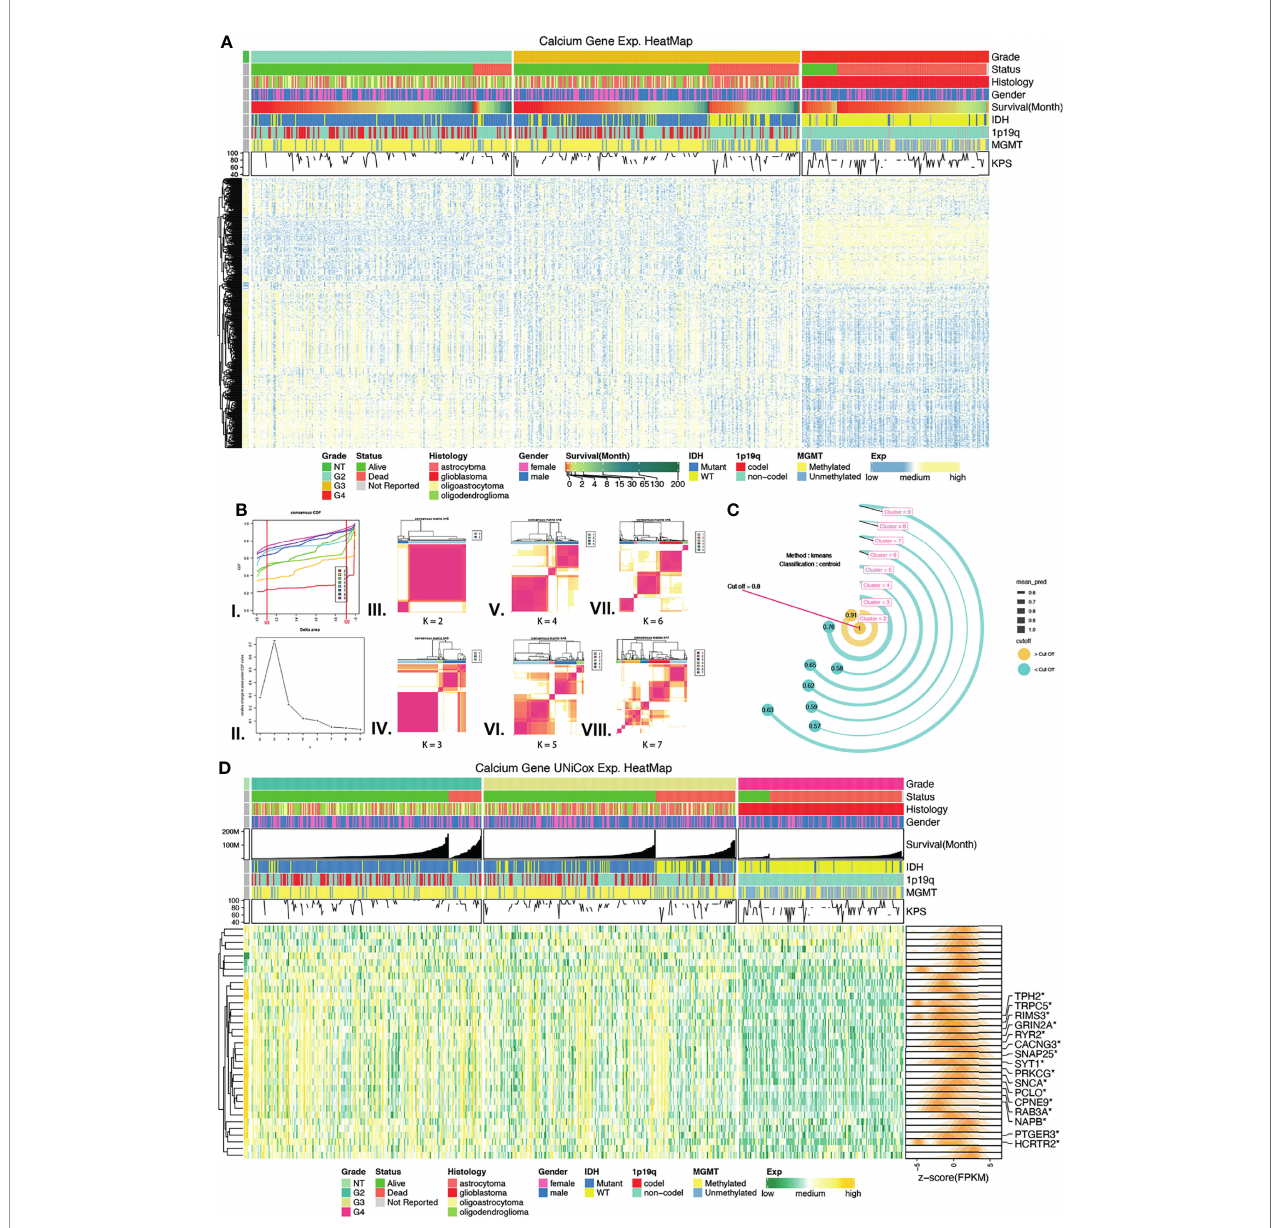
FIGURE 2 | Screening calcium key genes (CKGs) followed by unsupervised learning. (A) Calcium Genes expression and clinical features heatmap among normal control tissues, grade 2, grade 3, and grade 4 glioma. (B) Unsupervised learning of consensus clustering with CKGs, (I.) Consensus CDF line chart, (II.) Consensus delta area line chart, (III – VIII.) Consensus matrixes when k value varies from 2 to 7. (C) External validation method of consensus clustering, bar in yellow color is prediction value greater than threshold value (0.8). (D) Heatmap for CKGs extremely associated with overall survival (p < 0.001, Univariate Cox regression) and marked in DEGs. *p <